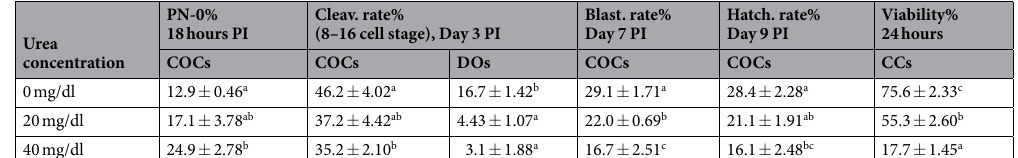
Table 1. Developmental competence of cumulus oocyte complexes and denuded oocytes, and the viability of cumulus cells in response to supplementation of maturation medium with the different levels of urea. Respectively, 210, 230, and 235 cumulus oocyte complexes (COCs) and 180, 210, and 200 denuded oocytes (DOs) were randomly allocated to the groups supplemented with 0, 20, or 40 mg/dl urea. Cumulus cells (CCs) had a density of 2 × 10 5 cells/ml. The cleavage rate (8–16 cell stage, day 3 post-insemination), blastocyst rate (day 7 post-insemination), and hatching rate (day 9 post-insemination) were recorded based on the number of COCs or DOs cultured in the maturation medium. The viability of 24-h cultured CCs under different levels of